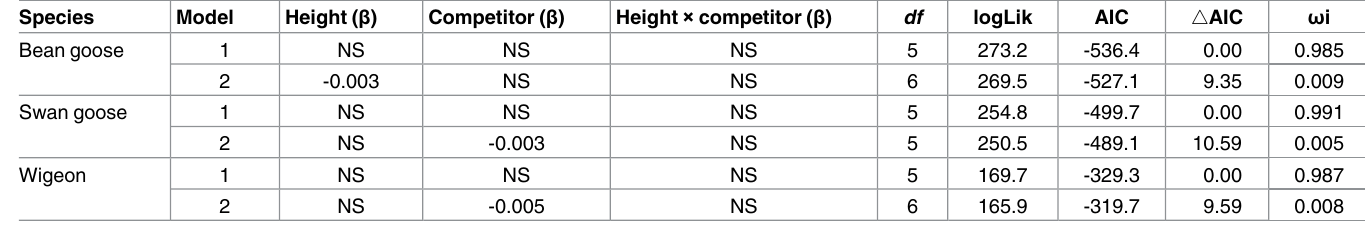
Table 3. Results of the best GLMMs to test whether the percentage feeding time (arcsin transformed) was affected by sward height and competi- tors based on AIC. In the model sward height, competitor and their interaction term were included as fixed factors, whereas session, enclosurenumber, and individualwere always includedas random factors in all models. NS indicatesthat the parameter was not included in the model. All models with 4 AIC < 2, and the next best model are reported (AIC = Akaike Information Criterion. df ; logLik, 4 AIC = AIC(i)—AIC(min); ω i = Akaike weights).